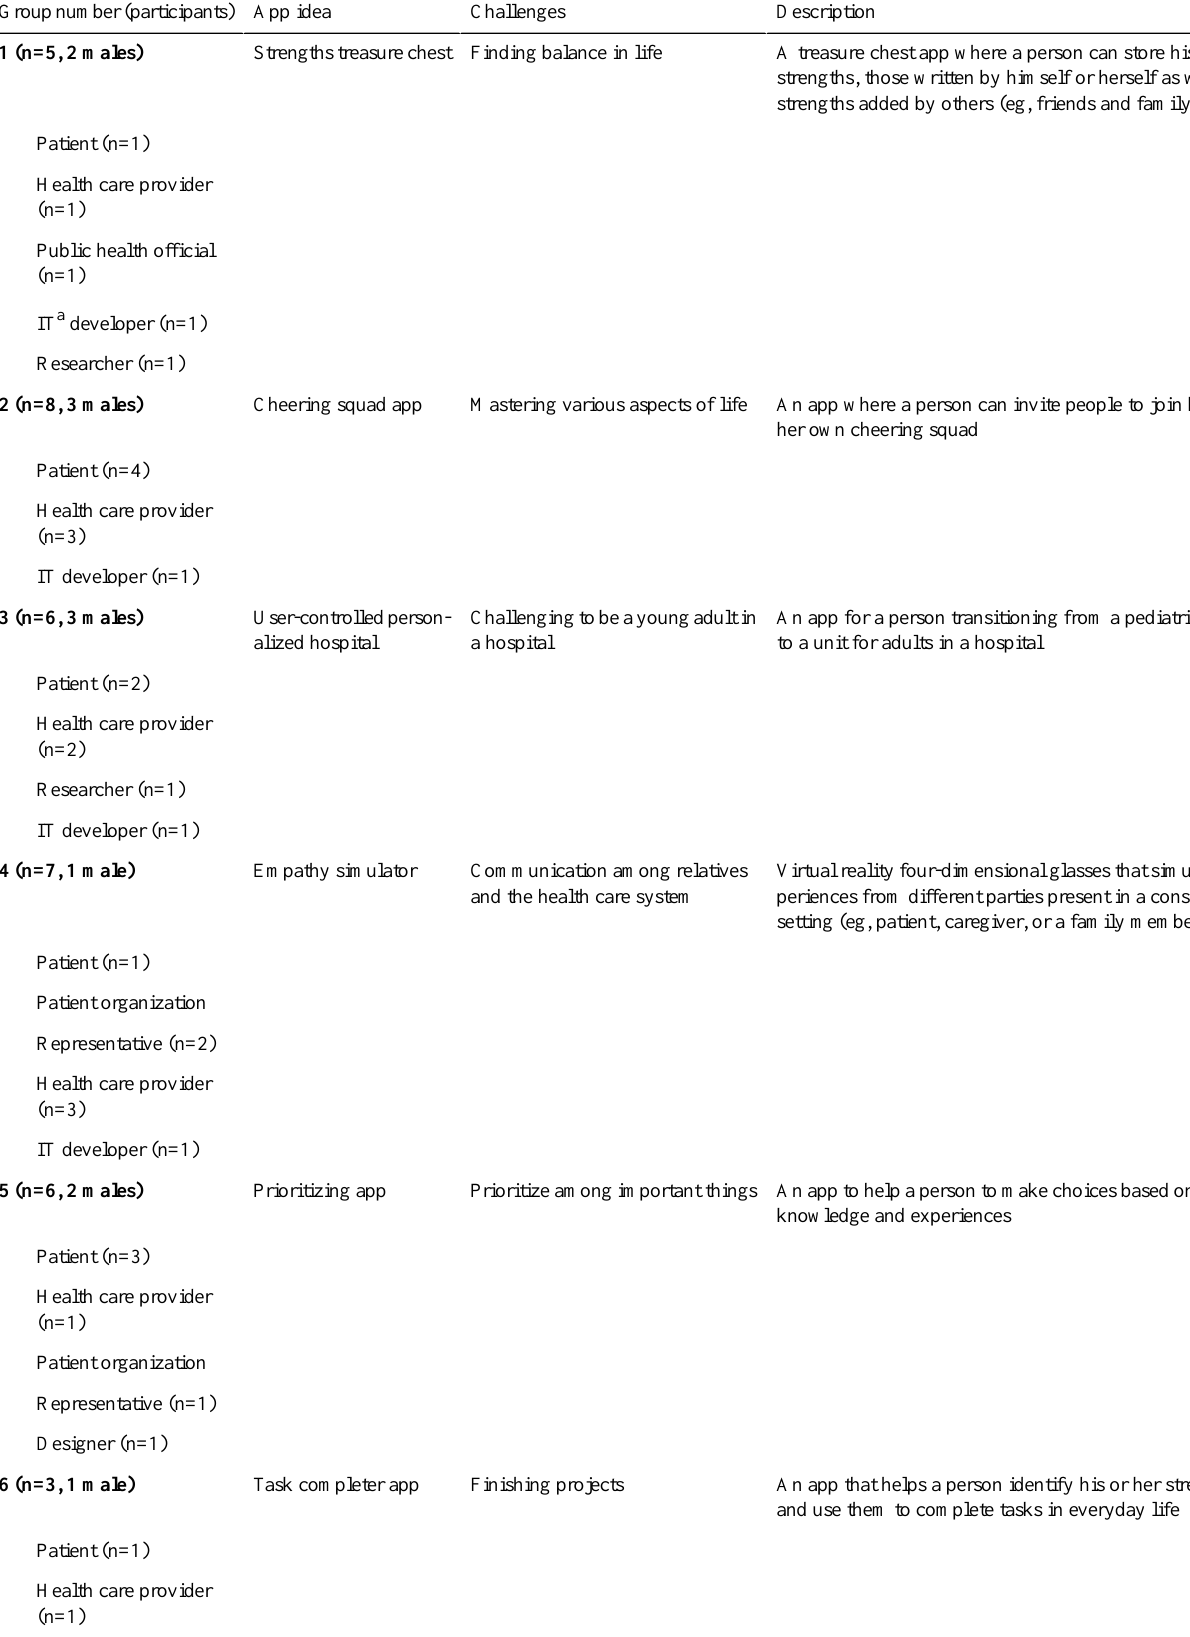
Table 1. Six proposed mobile health or electronic health tools from the idea-generating workshop (N=35, 13 males). DescriptionChallengesApp ideaGroup number (participants)